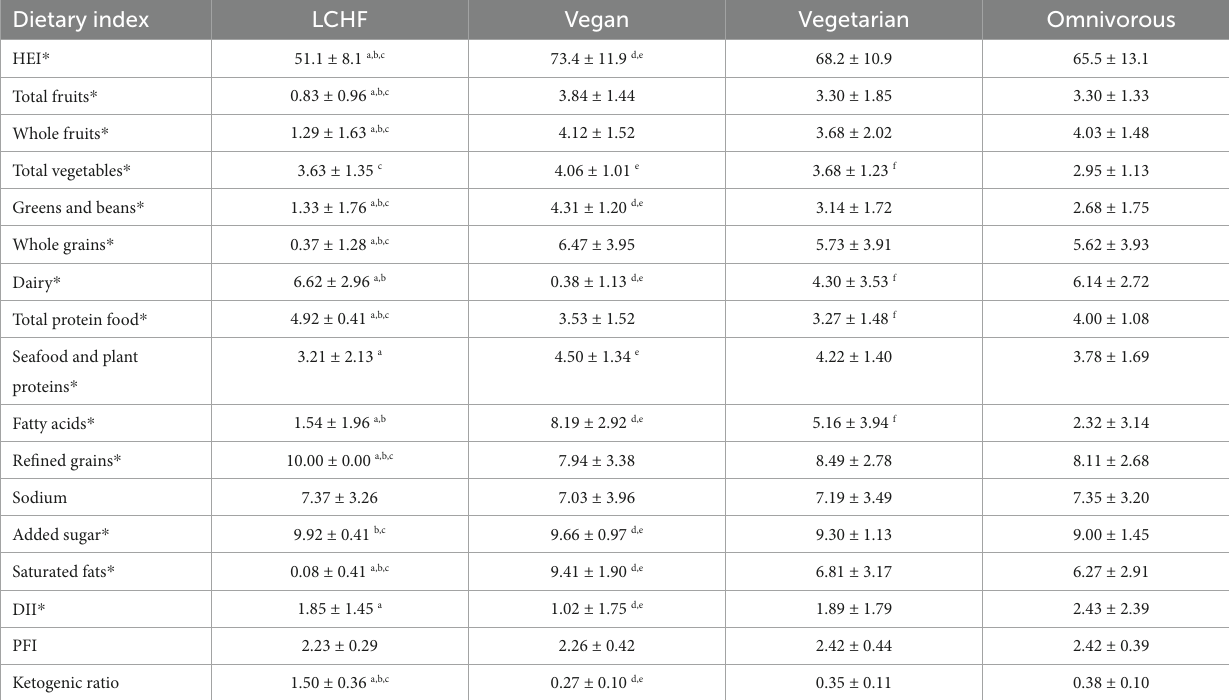
TABLE 4 Dietary indices. Dietary